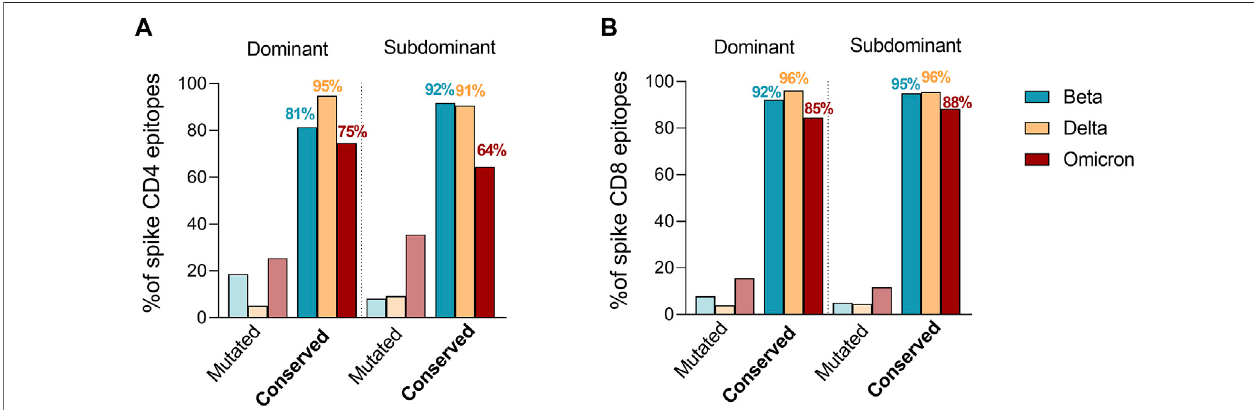
FIGURE1| EffectofBeta,DeltaandOmicronspikemutationsonTcellepitopeimmunodominance.PercentageofancestralSARS-CoV-2CD4 + (A) andCD8 + (B) TcellepitopesequencesaffectedbyBeta(green),Delta(yellow)andOmicron(red)variants.TheepitopelistwasextractedfromIEDB(www.IEDB.org)anddividedbased on a frequency of responders greater or equal than 3 (dominant) or less then 3 (subdominant). Percentages of conserved epitopes are noted per each SARS-CoV-2 variant separately.